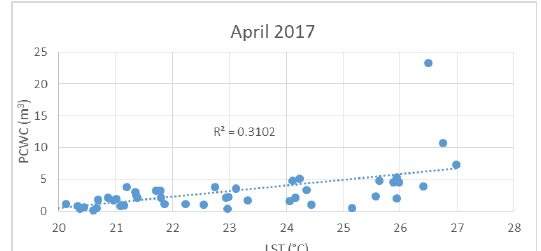
Figure 9. Correlation of LST and PCWC for the month